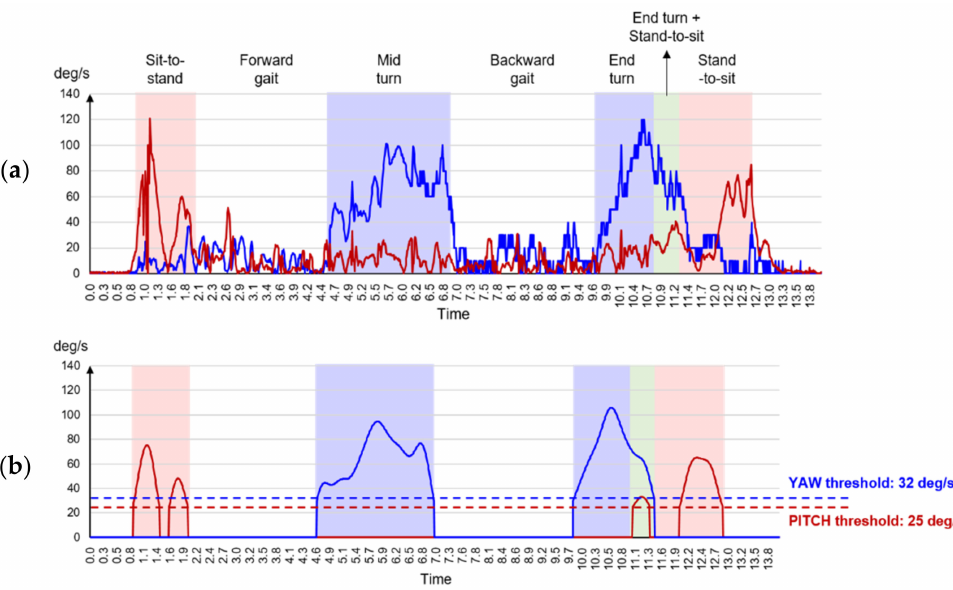
Figure 4. Example of identification of the TUG test sub-tasks (red line: PITCH signal; blue line: YAW signal): ( a ) rectification for raw data; ( b ) results of the TUG test data pre-processing for recognizing the TUG test sub-tasks.